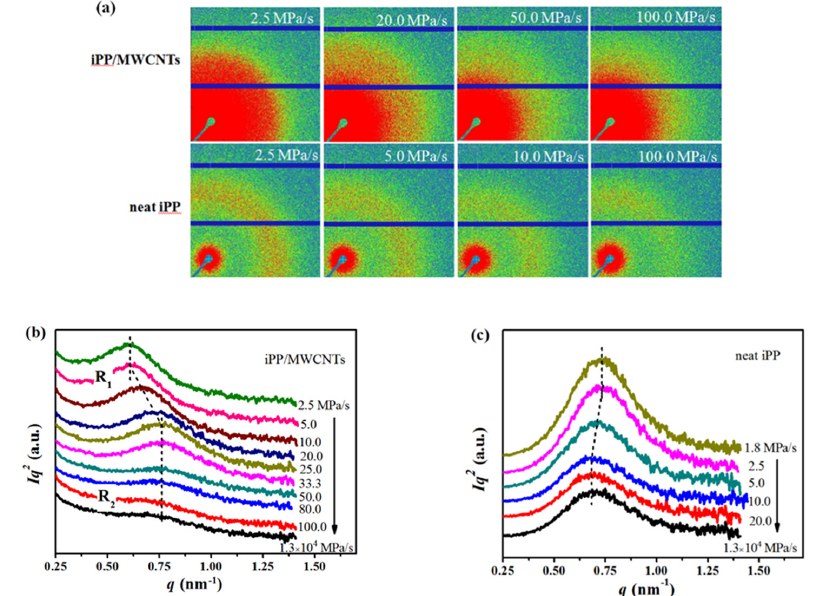
Figure 6. ( a ) Selected 2D small-angle X-ray scattering measurements (SAXS) patterns; 1D SAXS profiles of ( b ) iPP/MWCNTs and ( c ) neat iPP samples obtained by pressurizing the melts to 2.0 GPa at different pressurization rate.